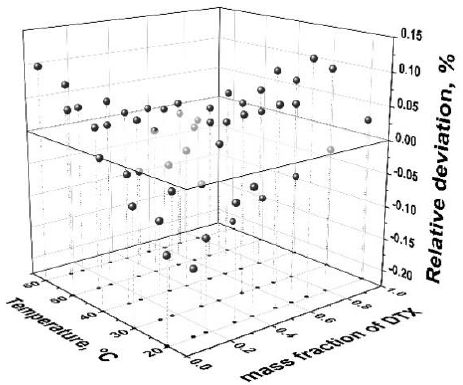
Figure 5. Relative deviations of experimental values of n D from values which are calculated using